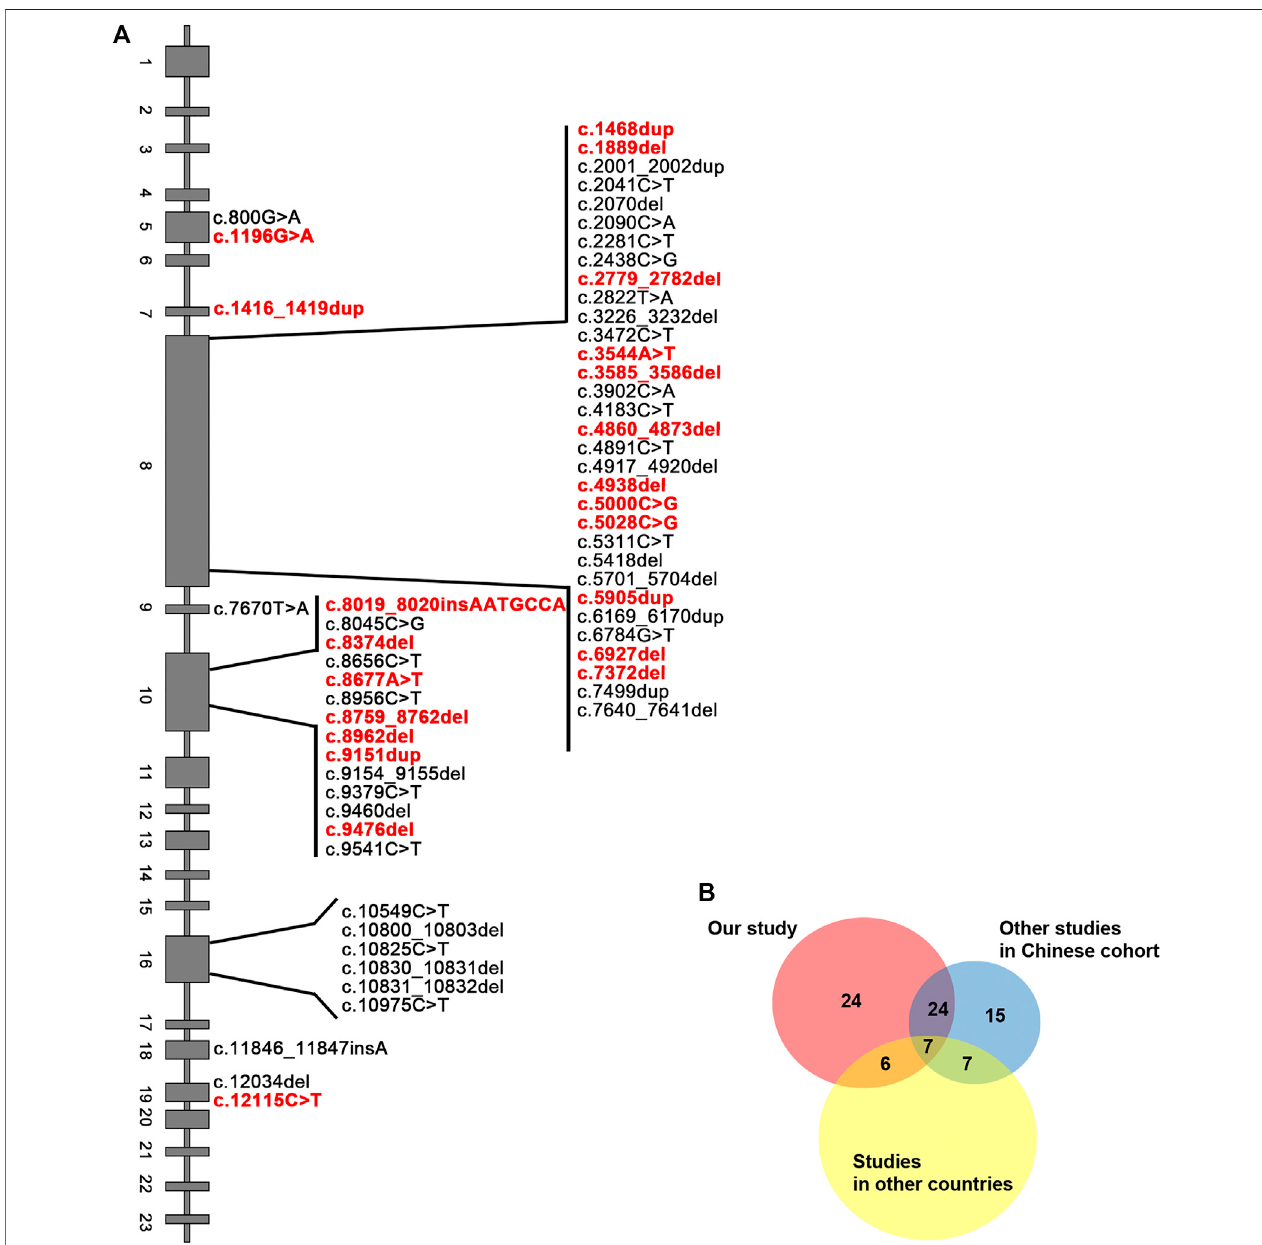
FIGURE 2 | Summary of ALMS1 variants. (A) ALMS1 variants identi fi ed in this study. Novel variants are shown in red. (B) Pie chart for the number of variants identi fi ed in our study and other